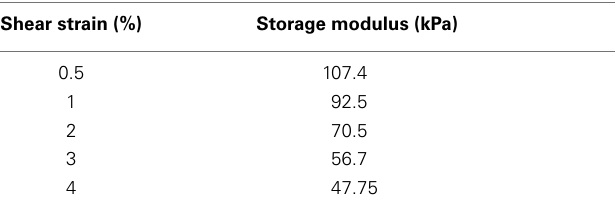
Table 1 | Storage modulus of MRSSE under different shear strain